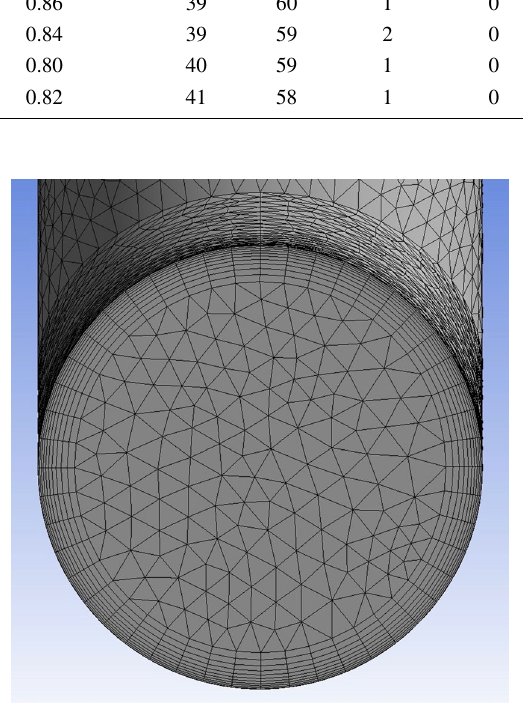
Fig. 4 Cross section of the mesh (Refsnes